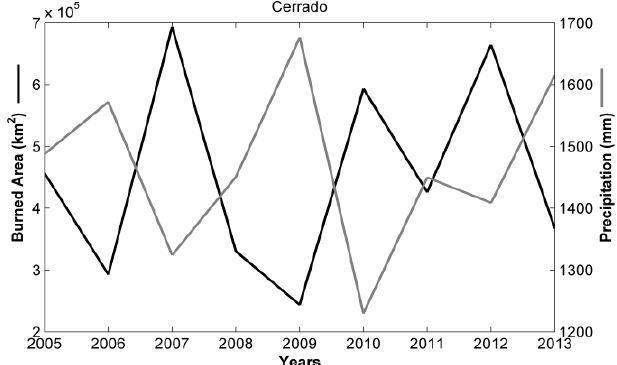
Figure 10. Inter-annual variability of burned area (black curve) and precipitation (gray curve) during the nine-year period (2005 to 2013) over